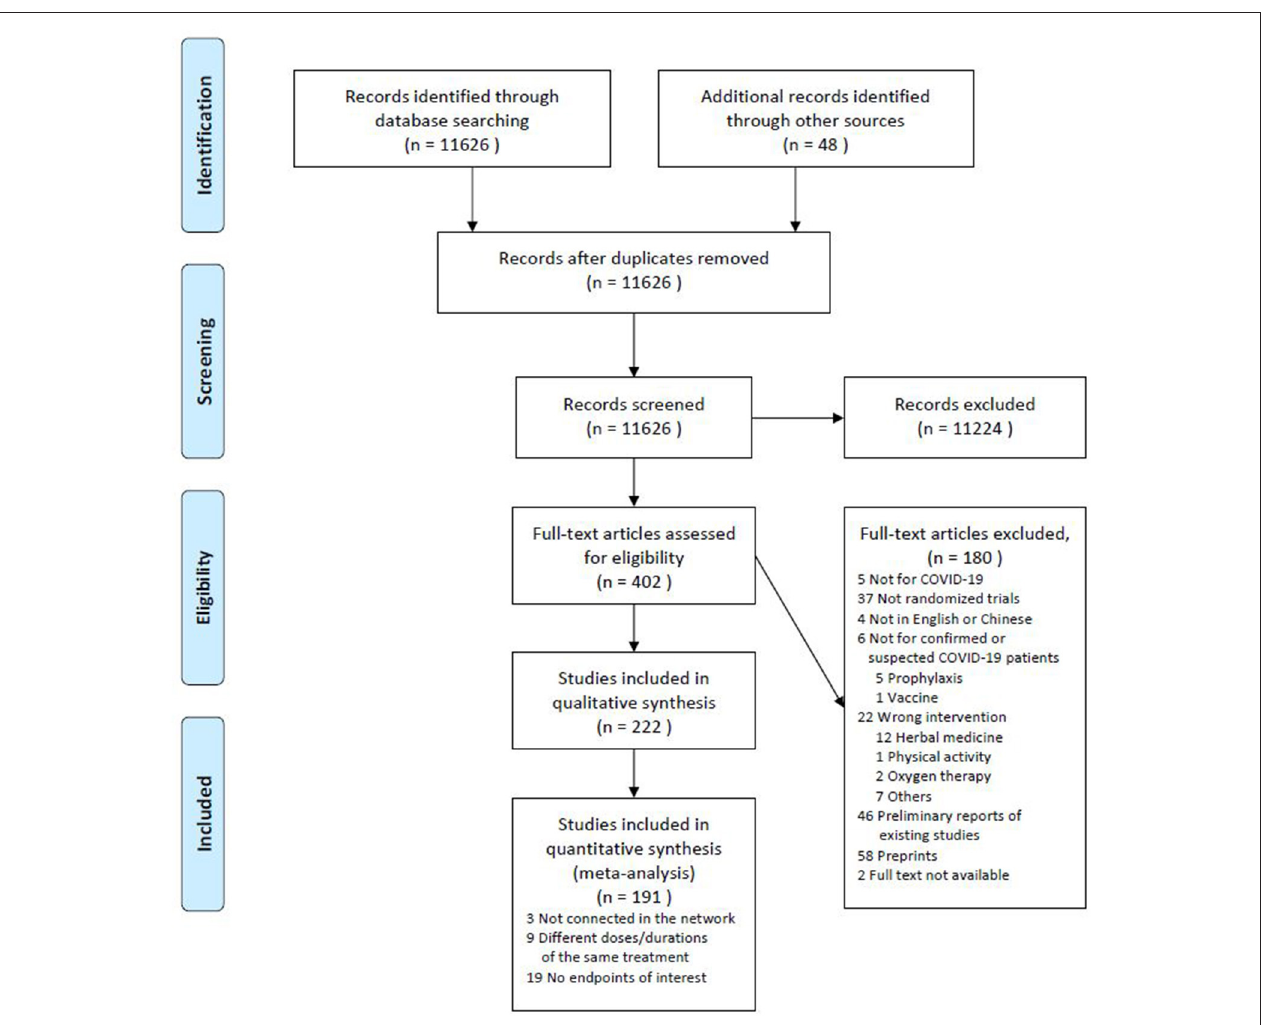
FIGURE 1 | Flow diagram of the study